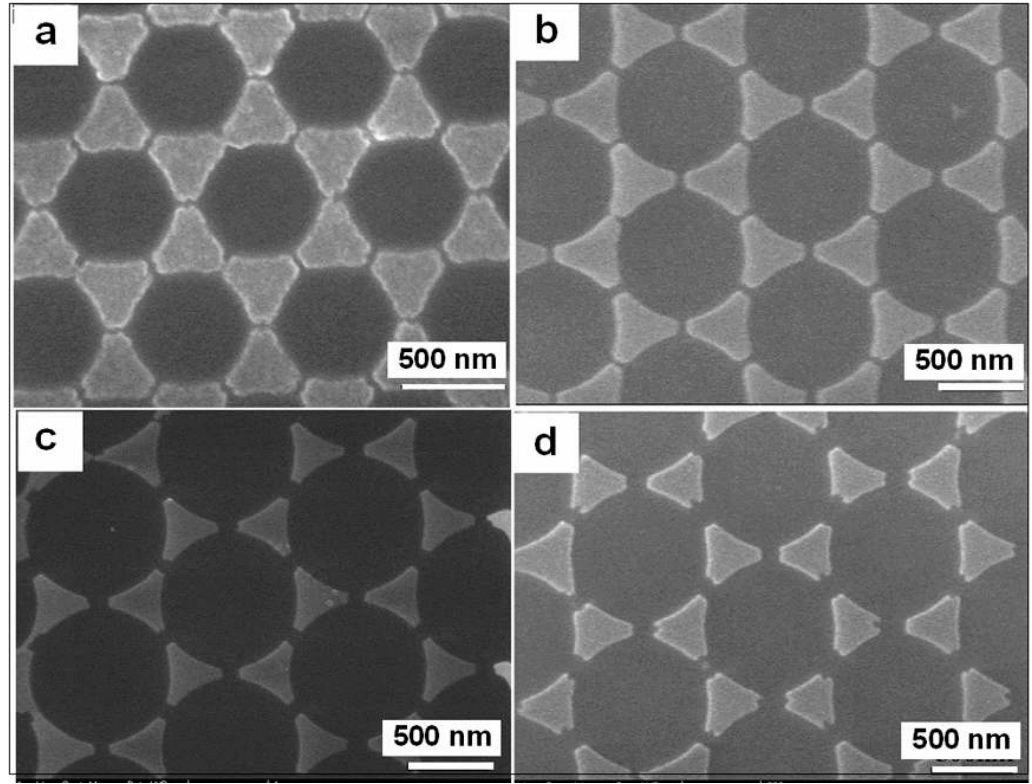
Figure 7. The SEM images of triangular gold nanoplate arrays with different spacings by sputtering deposition of Au on the hexagonal close-packed PS colloidal monolayers pre-heated at 120 °C for different durations and removing the PS spheres. ( a ): 0 min. ( b ): 1 min ( c ): 2 min. ( d ): 3 min.